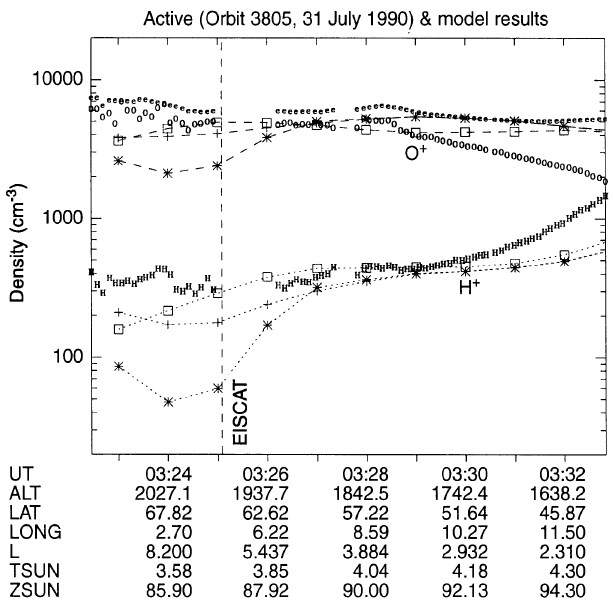
Fig. 6. As in Fig. 5, but for illustration of the effect of different convection patterns; maximum FACs in the 06 — 18 — MLT meridional plane ( curves with crosses ), 08 — 20 MLT ( astericks ) and 10 — 22 MLT ( squares